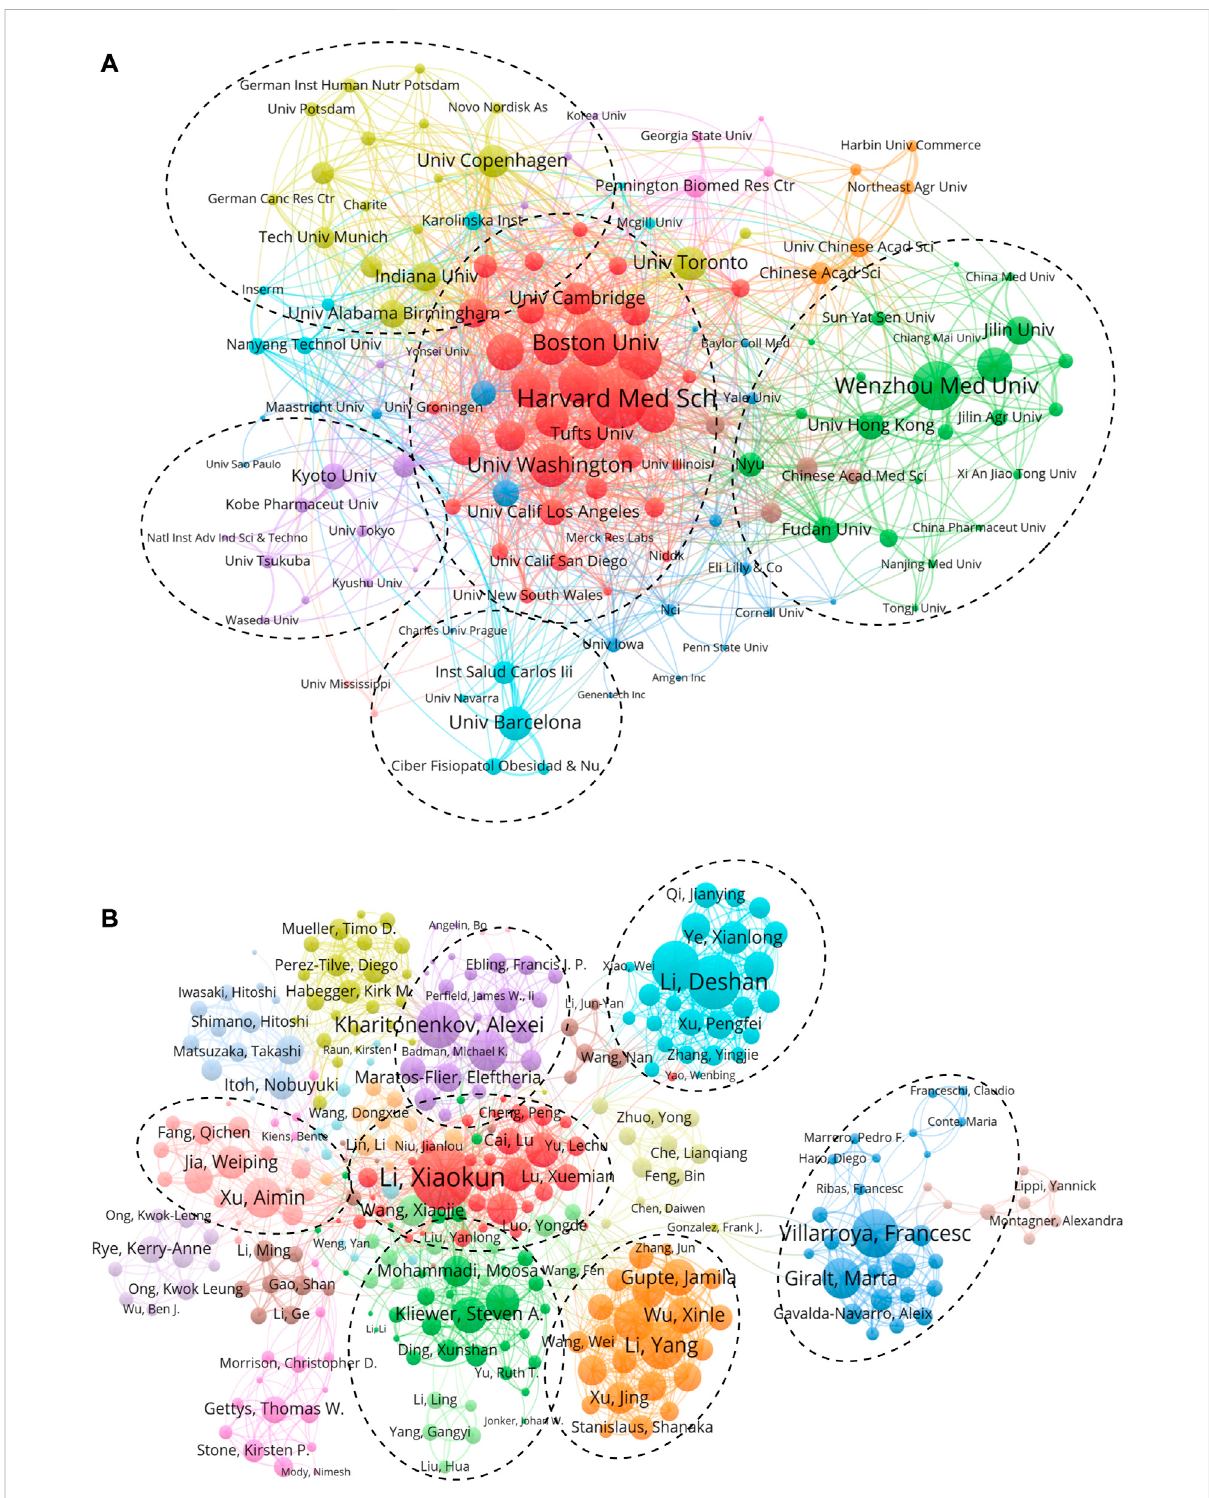
FIGURE 3 Active institutes and authors analysis. (A) Clustering of collaboration among institutes. (B) Clustering of collaboration among authors. In these maps, each institute or author is represented as a node, and each line means a co-authorship relationship. The node size is proportional to the collaboration link strength, and the line thickness indicates the collaboration link strength. In addition, the node color re fl ects the cluster to which it